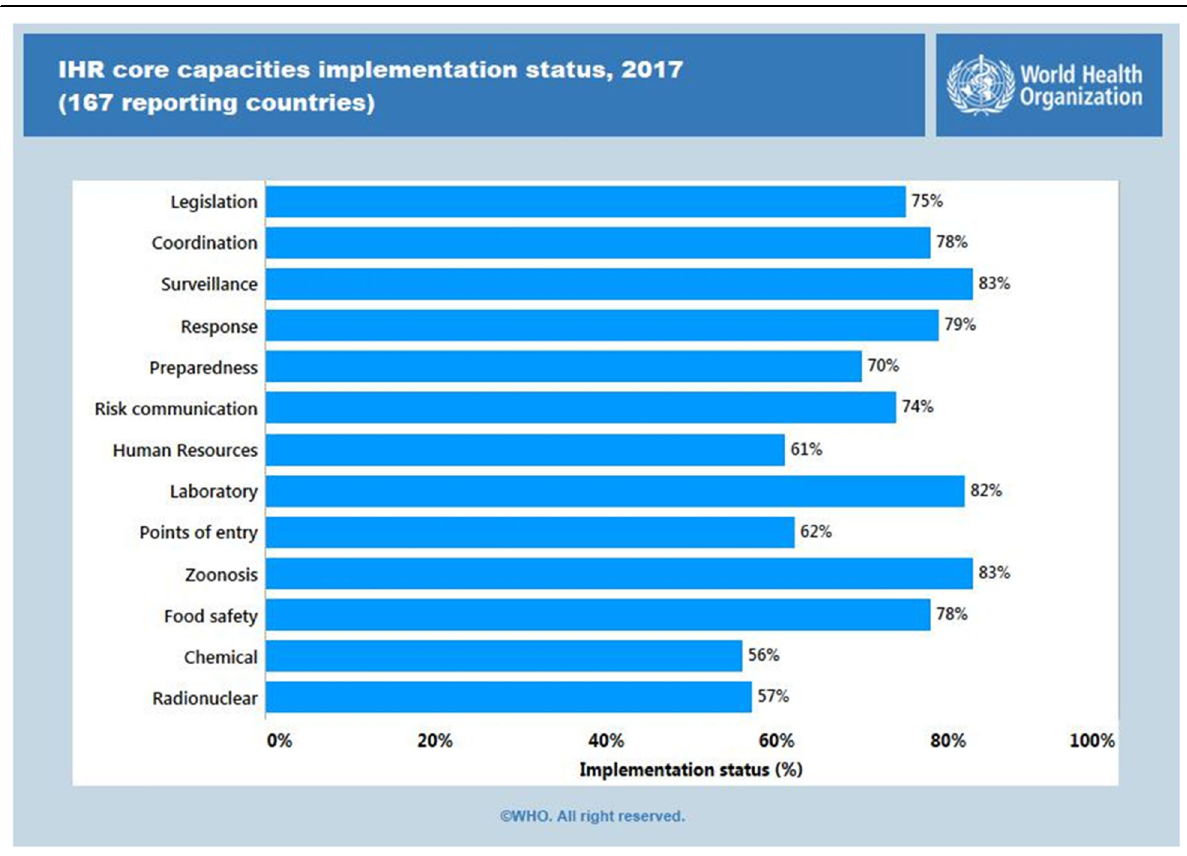
Fig. 6 The implementation and monitoring of core capacities continues to present a challenge in many technical areas (Source: The World Health